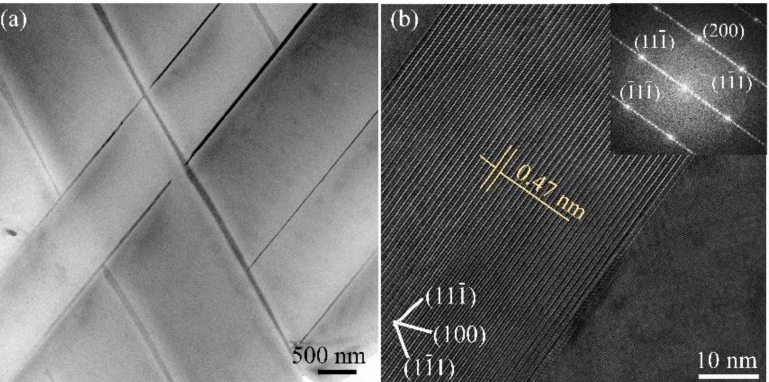
Figure 4. Large T 1 phase in the un-recrystallized grains in 2A97 alloy that solution treated at 520 ◦ C for 1 h and cooled by FC: ( a ) TEM image; ( b ) HRTEM image and FFT pattern of a single plate-like phase in ( a ).